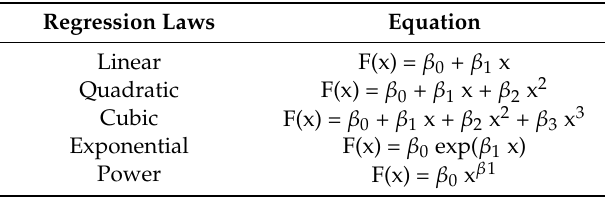
Table 1. Regression laws implemented in the calibration procedure.